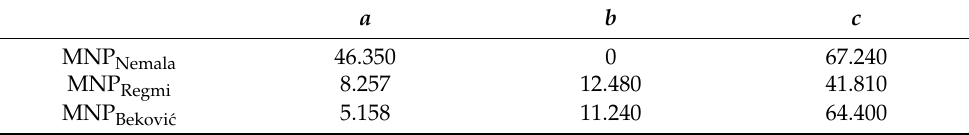
Table 3. Gaussian fitting parameters of SLP - T curves for the MNPs from references.